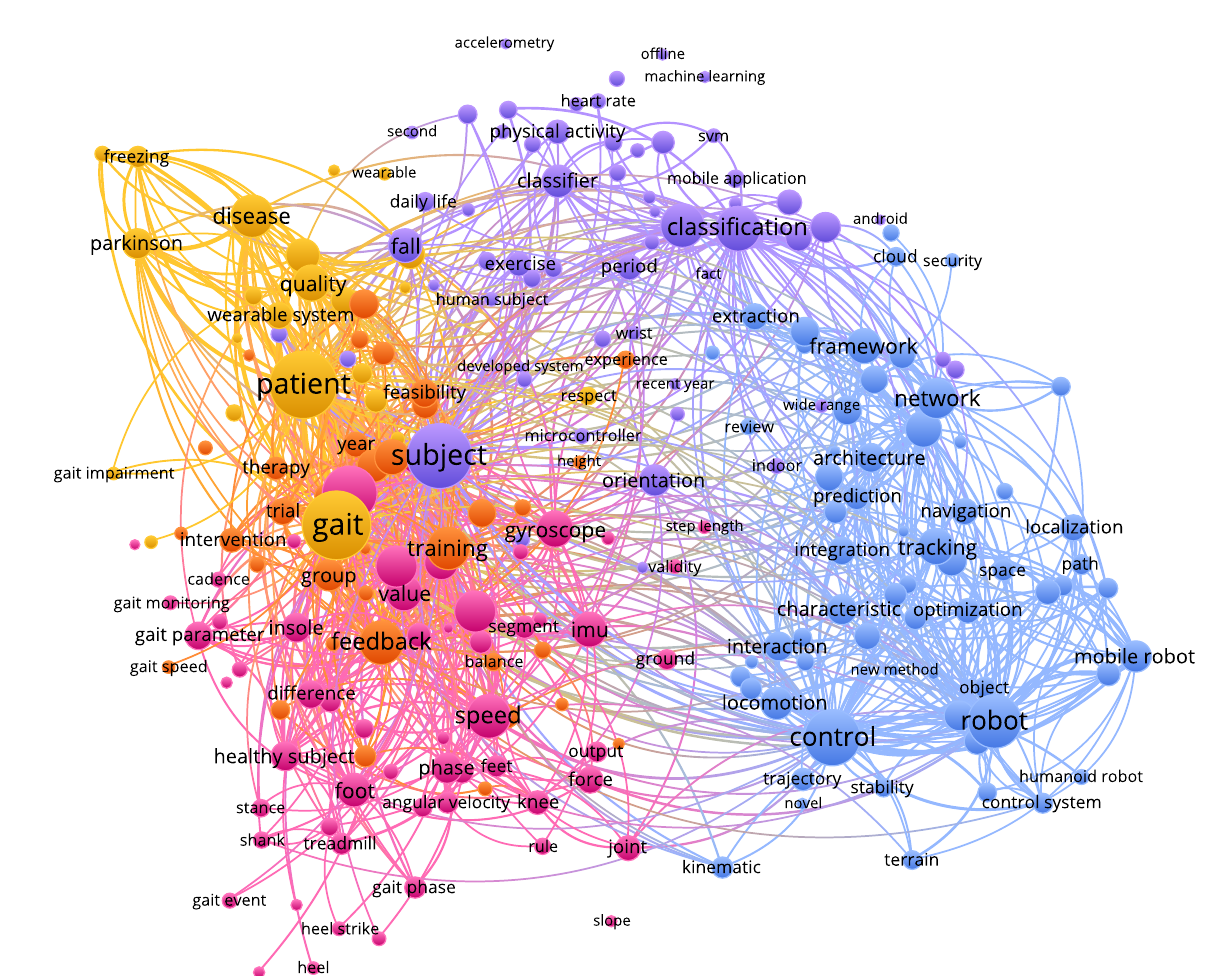
Figure 1. Word cloud showing most frequently occurring keywords present in search results for a search query in Scopus (for instance, see Table 2), visualized by the software VOS-Viewer [35]. The size of each node indicates the relative relevance (based on the frequency of occurrence of keywords) of that topic among the list of articles returned by the search query. Connections between nodes were not used in refining the search